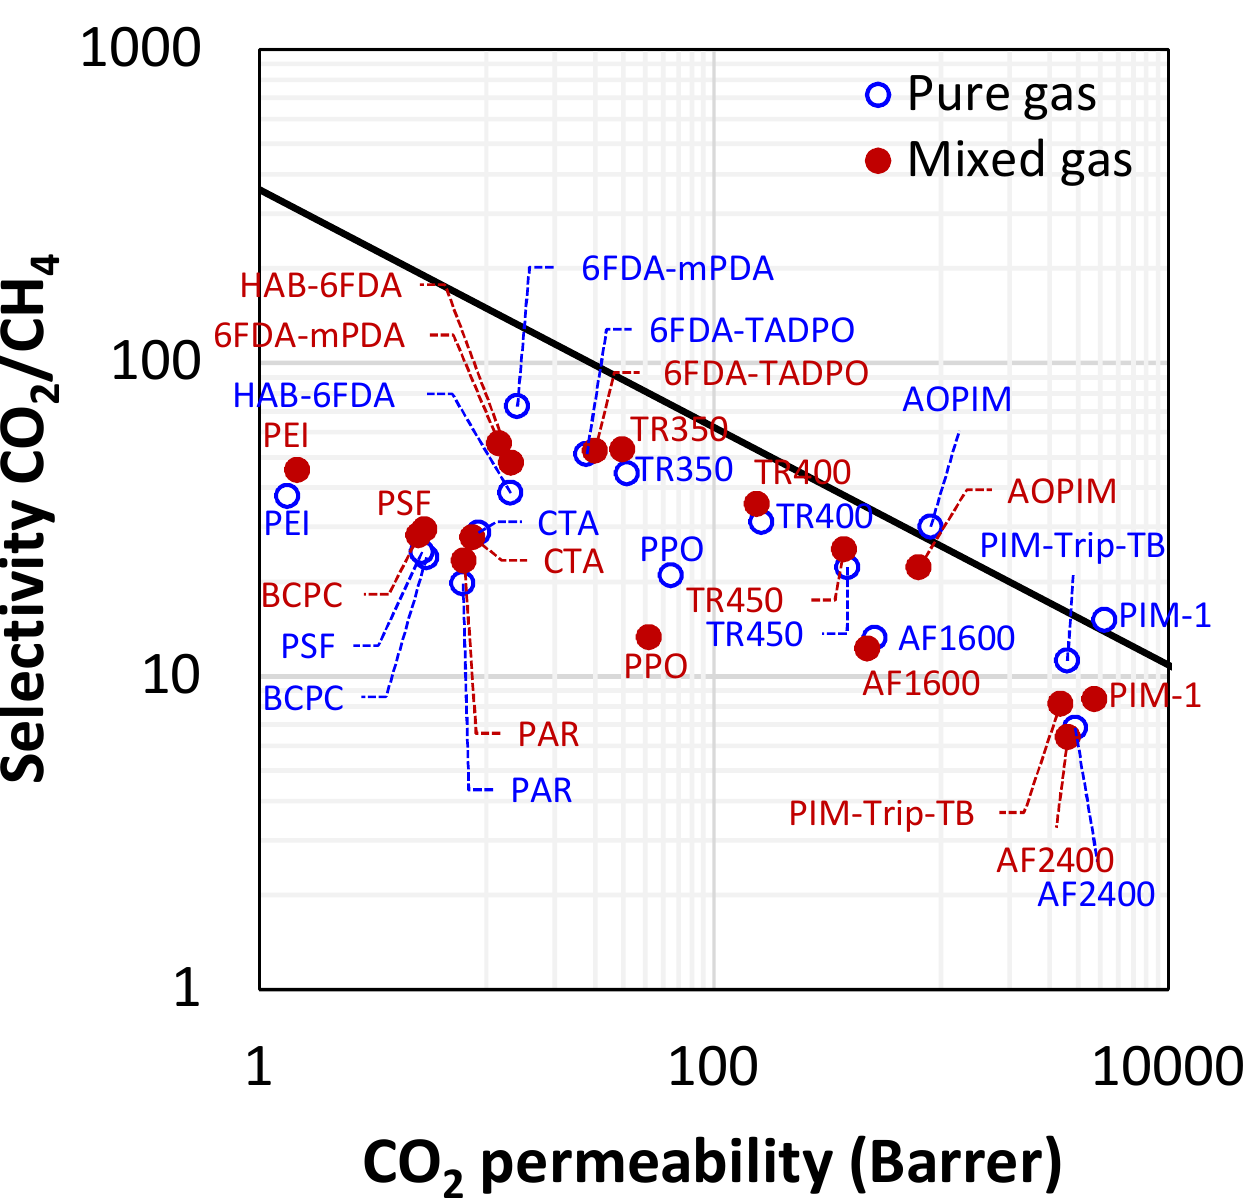
Figure 2. CO 2 /CH 4 upper bound for pure-gas (empty symbols) and ~50:50 mixed-gas measurements (filled symbols) at 35 ◦ C and 10 bar for 6FDA-TADPO [27], 6FDA-mPDA [38], PEI [81], PSF Figure 2. CO /CH upper bound for pure-gas (empty symbols) and ~ 50:50 mixed-gas measure- 2 4 ments (filled symbols) at 35 °C and 10 bar for 6FDA-TADPO [27], 6FDA-mPDA [38], PEI [81], PSF [81], CTA [82], PAR [81], PPO [83], HAB-6FDA [84], TR350 [84], TR400 [84], TR450 [84], AF1600 [85],